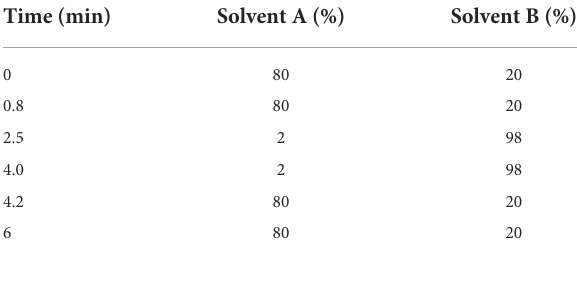
TABLE 1 Gradient elution conditions of ultra-high performance liquid chromatography